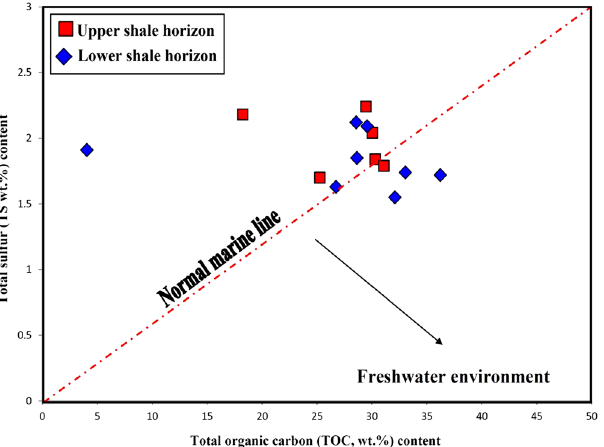
Figure 6. Cross-plot of the sulfur content plotted against TOC (wt%), suggesting a marine environment, with little connection to the freshwater (Paralic setting) during deposition of the analyzed Palana shales (modified after Berner and Raiswell 18